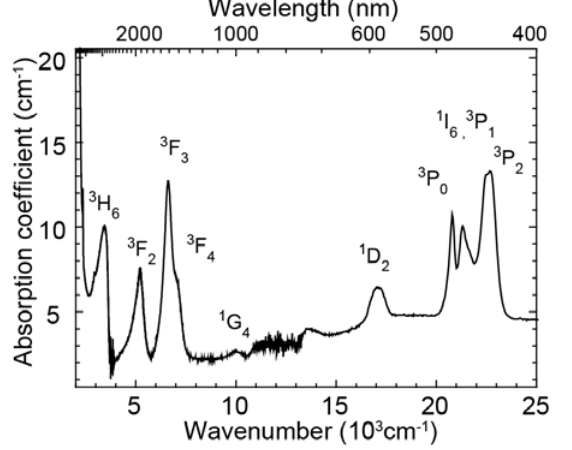
Figure 1. Absorption spectrum of the Pr 3+ singly doped oxyfluoride glass (x =